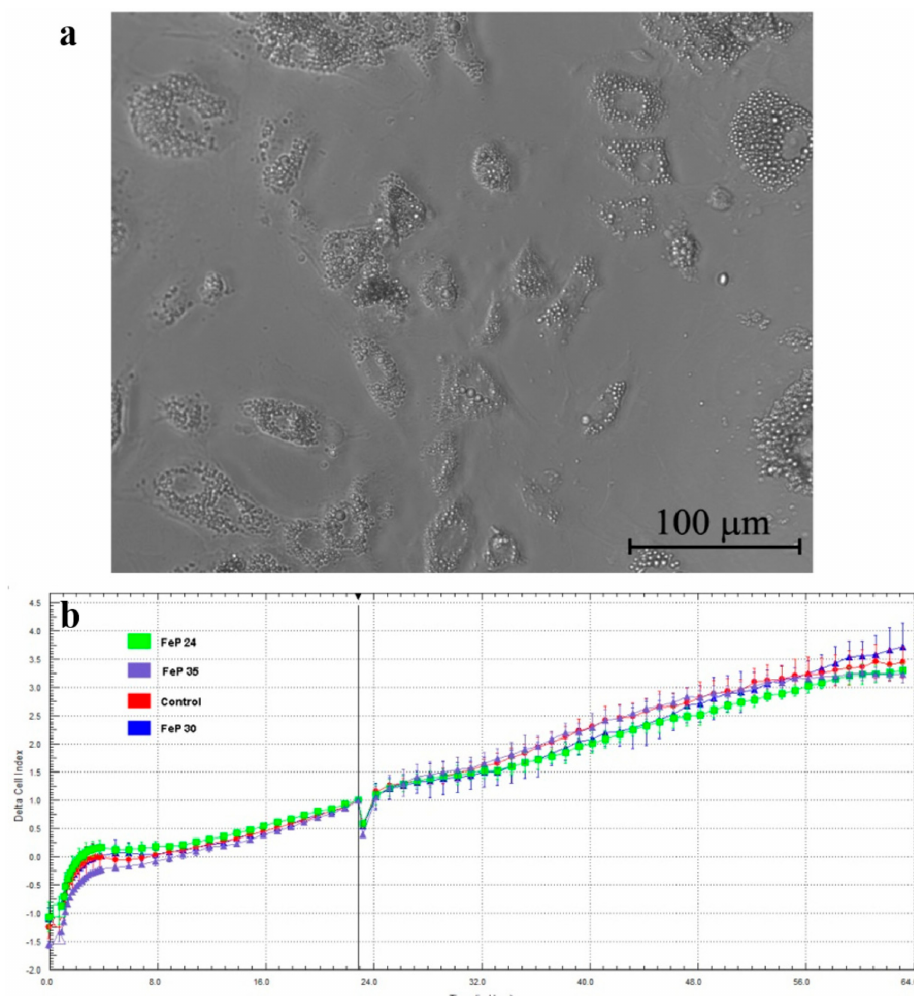
Figure A2. Biocompatibility of Fe-PEI NPs. ( a ) Phase-contrast microscopy illustrating the healthy aspect of endothelial progenitor cells (EPCs) after interaction with NPs. Note the specific accumulation of NPs as aggregates onto cell surface. ( b ) XCELLigence analysis illustrating that addition of NPs to cell culture does not affect cell index (a measure of cell morphology, cell adherence to substrate and cell proliferation rate). Three different NPs were used for this analysis, which were all obtained in the same synthesis conditions (initial mass ratio Fe:PEI = 1:2, 100 atm, 1 h, 40 ◦ C, stabilization in PAA-saline solution, see main text for